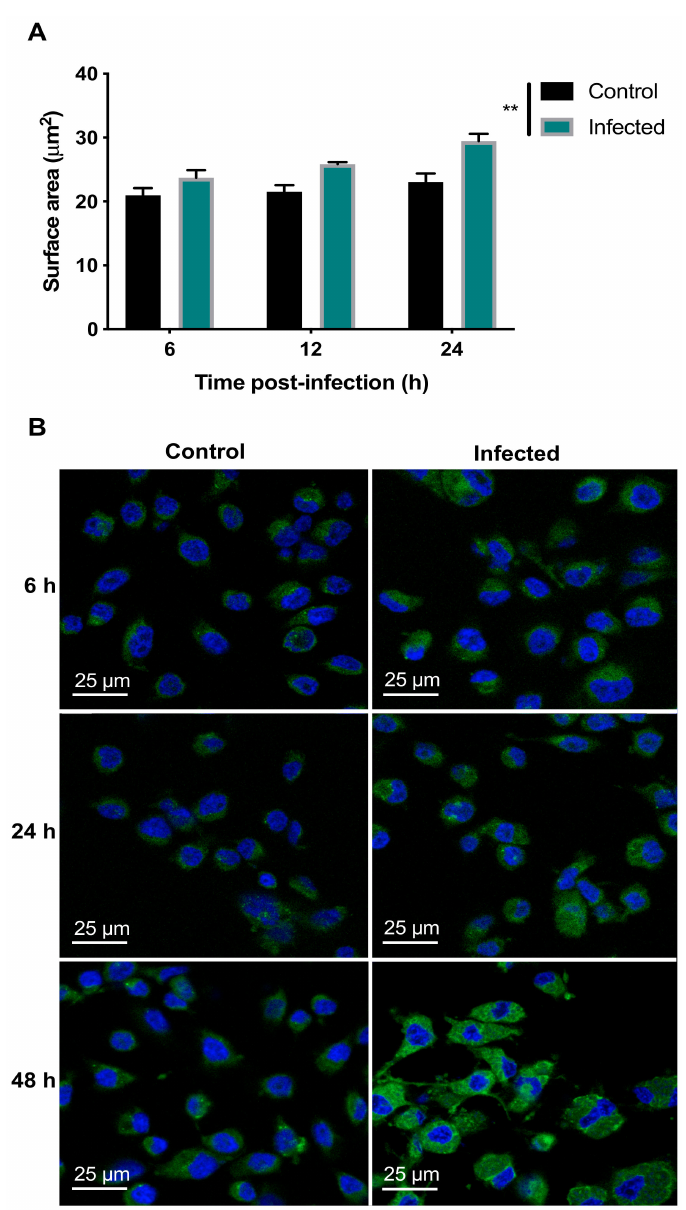
Figure 5. T. gondii increased the lipid content of the infected BMECs. ( A ) Infected cells exhibited increased LipidTox ™ green fluorescence intensity, compared to control cells (** p < 0.01). ( B ) Representative images of BMECs infected by T. gondii showing increased lipid staining denoted as green dots and blue host cell nuclei stained with 4 (cid:48) ,6-diamidino-2-phenylindole